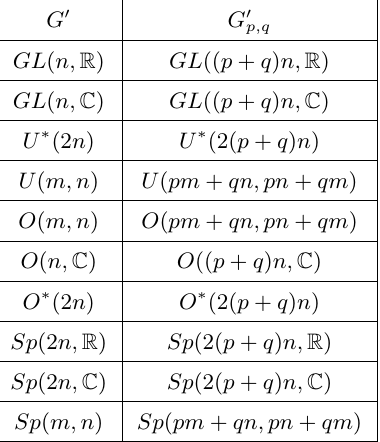
Table 2 . The list of G 0